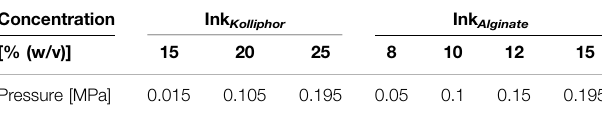
TABLE 2 | Set pressures applied during fi lling level investigations for the ink with the respective alginate and Kolliphor concentration. Concentration Ink